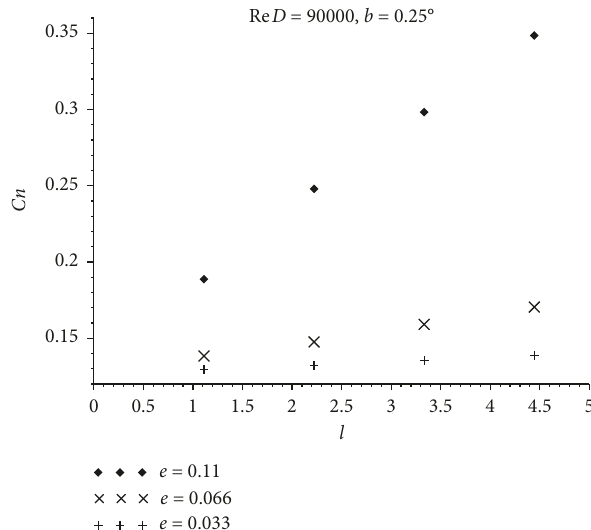
Figure 14: Evolution of Cn with an obstacle for a small con- finement gx � gy � 0.22 as a function of the length of the obstacle l.